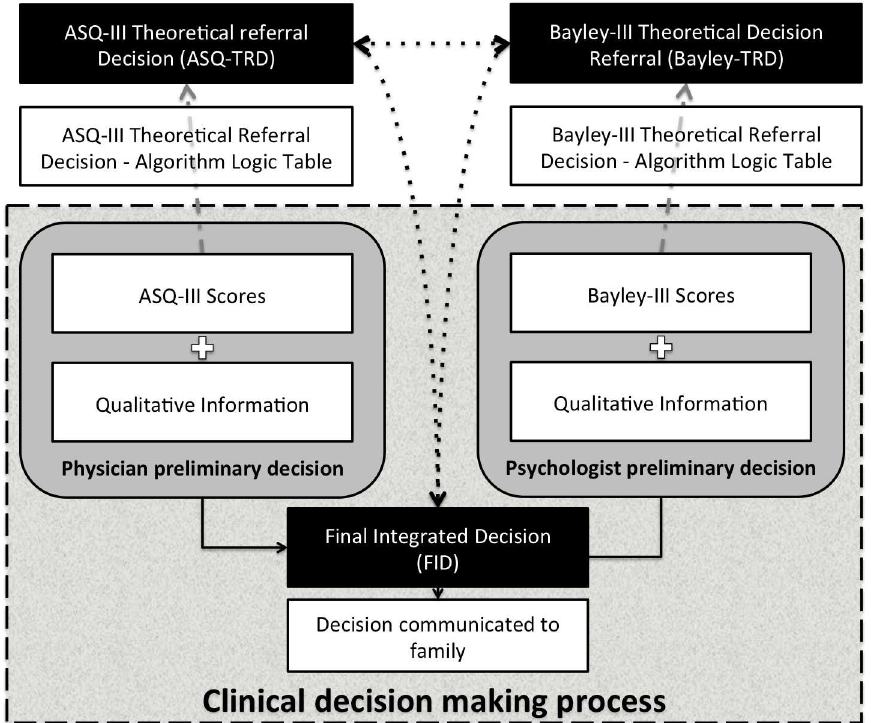
Fig 1. 18 months old corrected gestational age decision-making process and analysis. Qualitative information includesinformationgatheredfrom the medical, behavioral and socio-family environmental assessment and the neurologicalexam. ASQ, Ages and Stages Questionnaire; Bayley-III, Bayley Scales of Infant Development3 rd edition; FID, Final integrateddecision;TRD, Theoreticalreferral